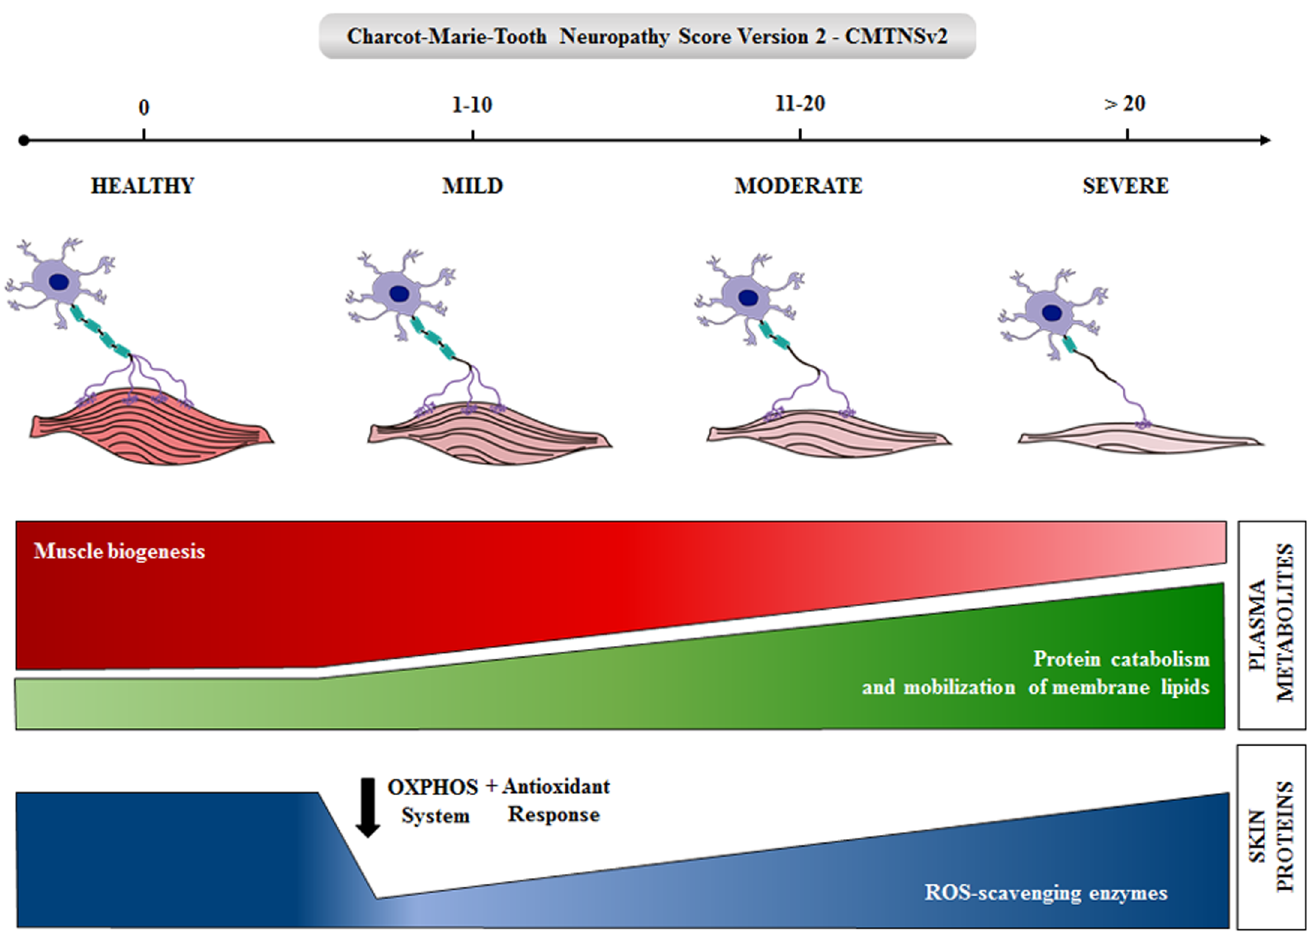
Fig 6. Summary of the major changes in the expression of skin and plasma metabolites during progression of CMT1A. The loss of muscle and nerves is shown duringseverity of the disease as revealedby the CMT neuropathyscore v2. The changesin biomarkers are illustratedby row